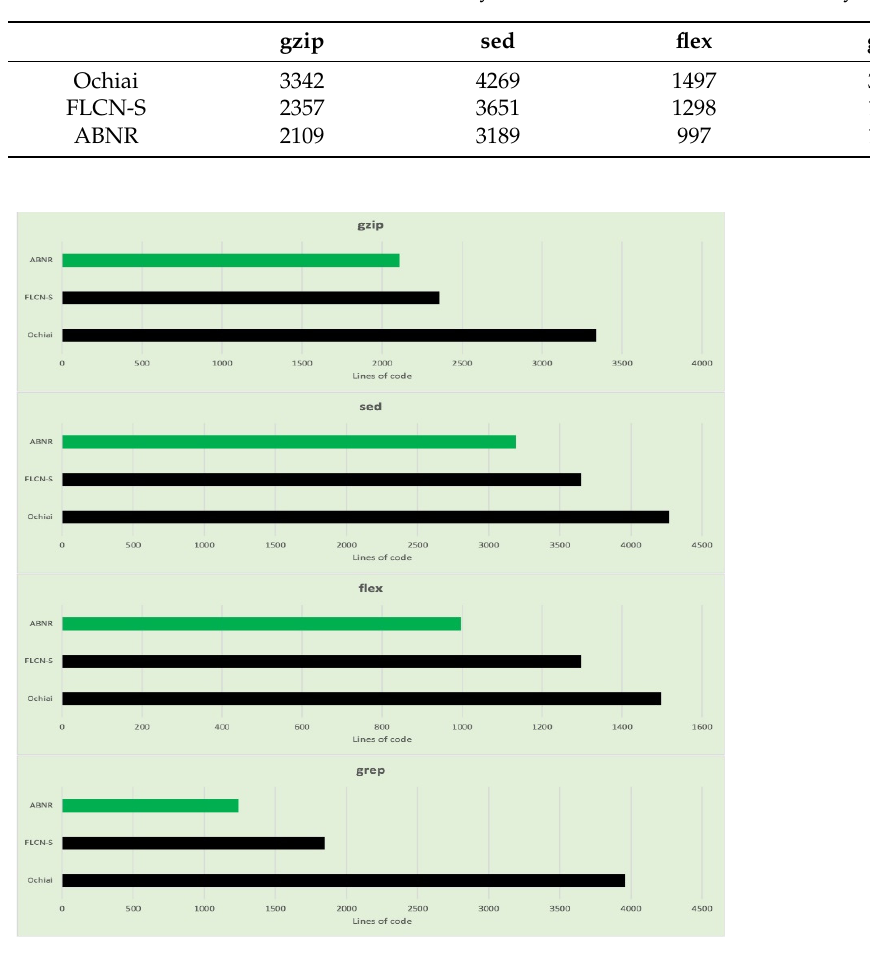
Table 8. Denote the confidence level of fault detection from Siemen’s validation set.